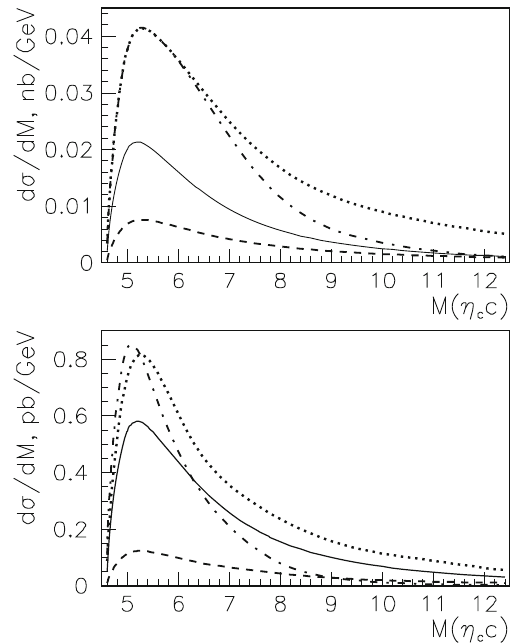
Fig. 5 The process g + g → η c + c + ¯ c ; the distributions over the frag- mentation variable z as seen under the different kinematic constraints. > 20 GeV; dashed, p η > Upper panel: dotted, p η T > 5 GeV, p ∗ > 20 GeV; dashed, p η > 20 GeV, p ∗ > T T T T T > 20 GeV; dash-dotted, m ∗ < E ∗ / 3; solid, factorization 20 GeV, p ∗ T > 20 GeV. Lower panel: dotted, p η > 20 GeV, calculation for p ∗ > 20 GeV, p ∗ > 50 GeV; T T T T > 50 GeV; dashed, p η > 50 GeV, p ∗ > 50 GeV; dash-dotted, p ∗ > 50 GeV; dash-dotted, m ∗ < E ∗ / 10; T T T T > 50 m ∗ < E ∗ / 10; solid, factorization calculation for p ∗ > 50 GeV T T